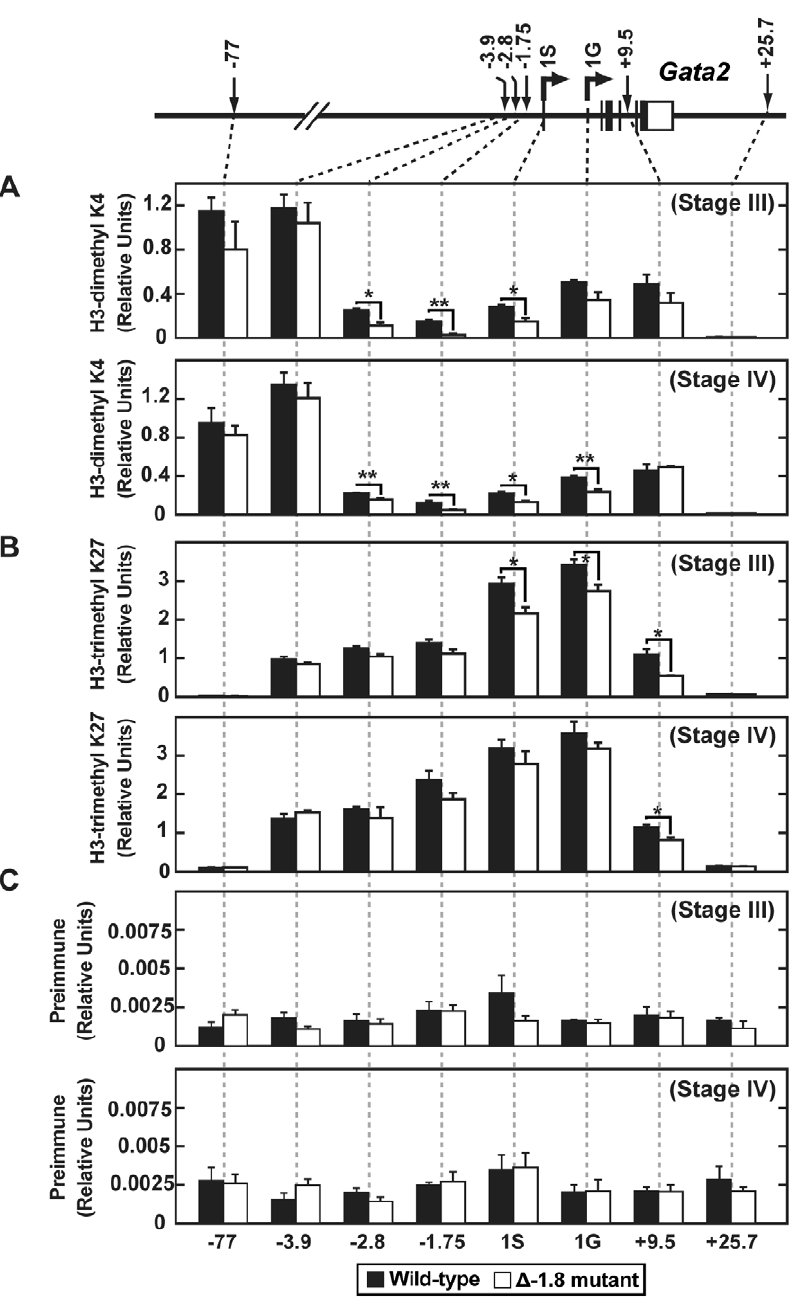
Figure 7. Loss of the 2 1.8 kb site alters dimeH3K4 and trimeH3K27 marks in Stage III and IV erythroblasts. Quantitative ChIP analysis across the Gata2 locus using antibodies to dimeH3K4 (A) and trimeH3K27 (B) and preimmune (C) in Stage III and Stage IV cells sorted from wild-type and D -1.8 embryos at E14.5. Calculations were derived using percentage of input and were normalized using relative units which were determined by defining 9% input sample as